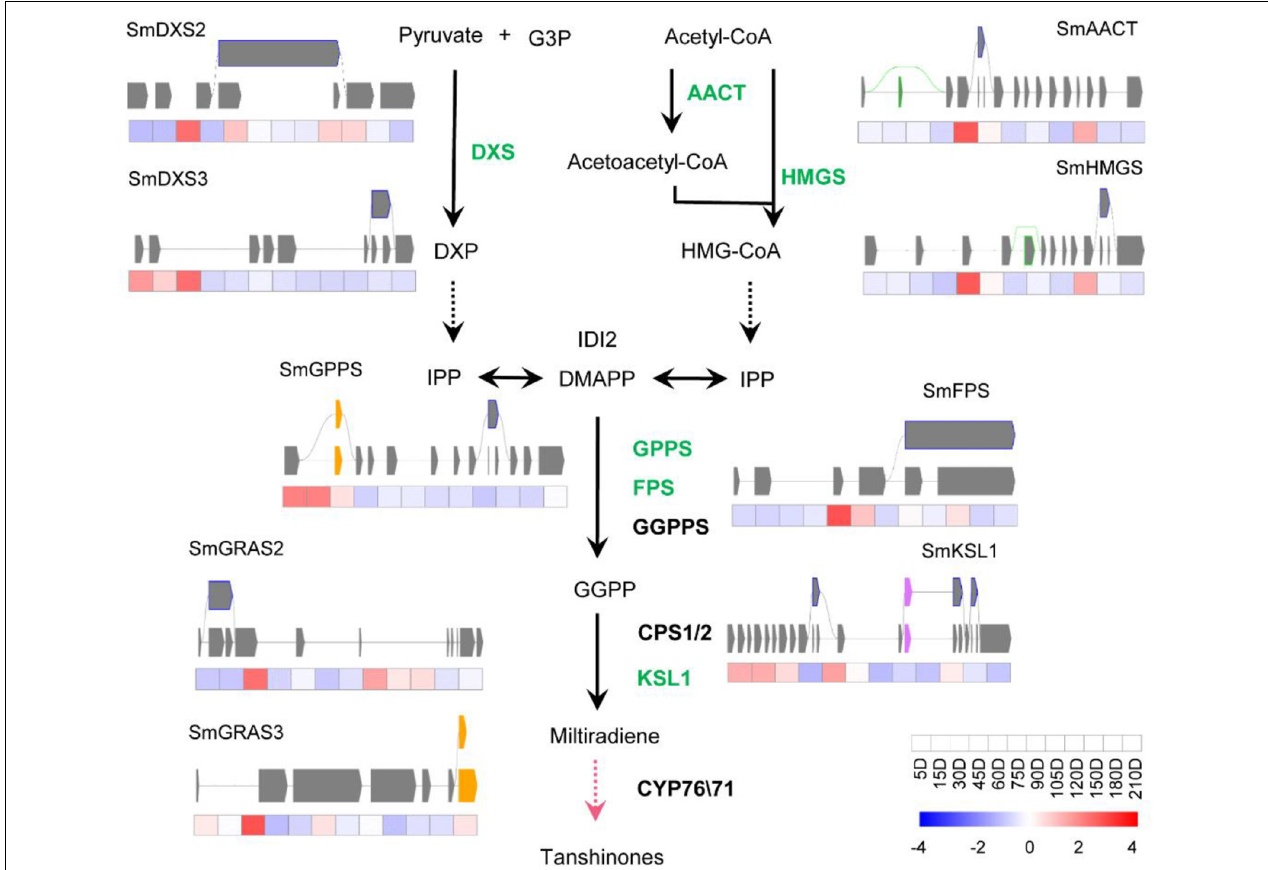
FIGURE 3 | Transcript levels and alternative splicing isoforms of tanshinones biosynthetic genes and TFs. The green font means the gene has undergone AS process. The yellow boxes, purple boxes, blue frames, and green frames indicate Alt.3 (cid:48) , Alt.5 (cid:48) , IR, and ES splicing patterns, respectively. The black lines indicate the known enzymes, the pink line indicates the unknown enzymes. The gay lines indicate introns, gray squares represent exons. Alternative splicing.